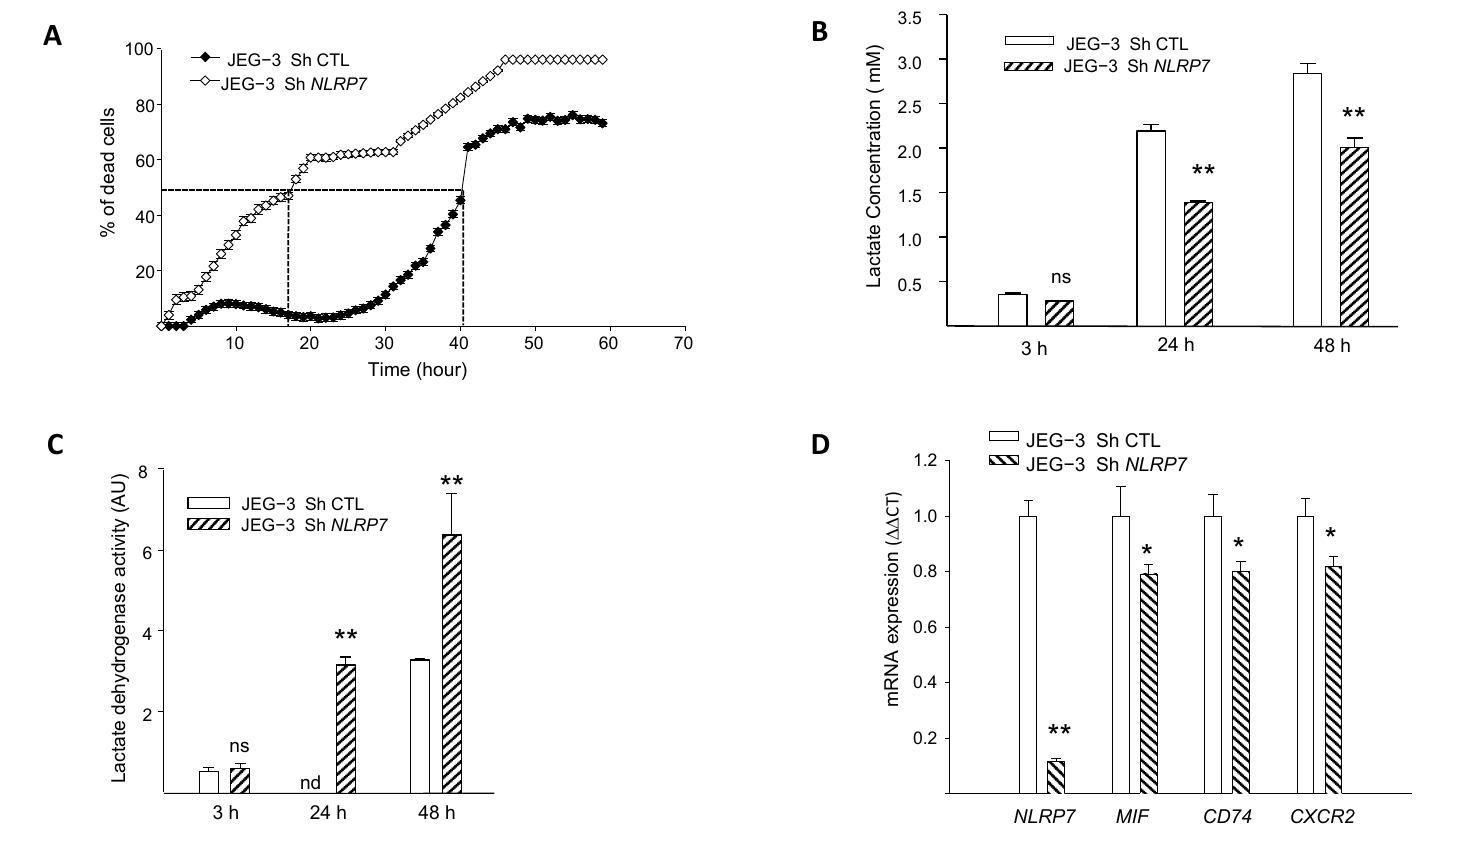
Figure 3. Comparison of JEG-3 cells survival under NLRP7 knockdown. ( A ) shows the survival curves of JEG-3 Sh CTL and JEG-3 Sh NLRP7 cells. Cells (10,000 cells/well) were pre-labeled with propidium iodide (5 µ g/mL) and then tracked with the Incucyte system, whereby pictures were captured every 2 h ( n = 12). ( B ) reports a comparison of lactate levels in the culture supernatants of JEG-3 Sh CTL and JEG-3 Sh NLRP7 cells collected at 3, 24, and 48 h of culture ( n = 6); ns: not-significant, ** p < 0.01. ( C ) reports a comparison of LDH activity in culture supernatants of JEG-3 Sh CTL and JEG-3 Sh NLRP7 cells collected at 3, 24, and 48 h of culture ( n = 6); ns not-significant, nd: not detected, ** p < 0.01. ( D ) reports comparisons of NLRP7 , MIF , CD74 , and CXCR2 mRNA levels in JEG-3 Sh CTL and JEG-3 Sh NLRP7 cells ( n = 3); * p < 0.05, ** p <